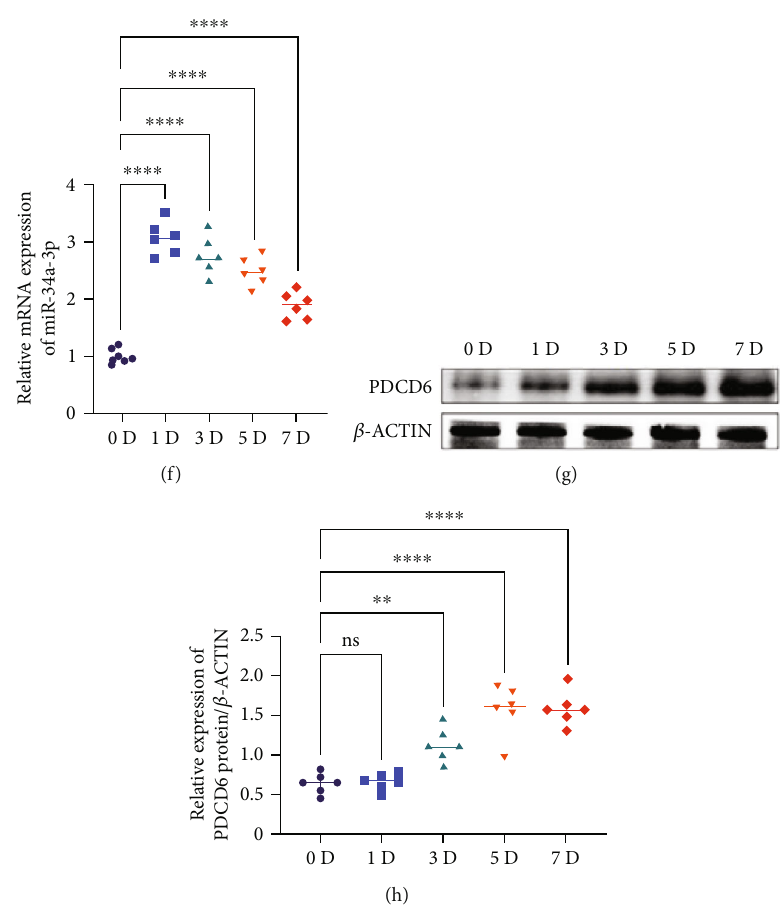
Figure 1: miR-34a-3p suppressed PDCD6 expression in di ff erentiating NSCs time-dependently. (a) Phenotypic characterization of isolated NSCs. The cells were stained for Nestin, GFAP, β III tubulin, and Olig2 to determine their expression on NSCs. The representative images of six ( n = 6 ) independent experiments are shown for each group. (b) miR-34a-3p directly binds to the 3 ′ UTR of PDCD6 (position 737-743); the sequence marked in red represents the predicted miR-34a-3p binding site (with vertical lines indicating base pairing underneath) or mutated miR-34a-3p binding site (unable to bind to the miR-34a-3p sequence). (c) Relative luciferase activity of Renilla luciferase versus fi re fl y luciferase in di ff erent groups. The experiments were performed in triplicate and repeated six times ( n = 6 independent experiments). (d) Western blot analysis of PDCD6 protein expression in di ff erent treatment groups. Representative images of three independent experiments are presented. (e) Quanti fi cation of western blot bands of PDCD6. The gray values of six ( n = 6 ) independent experiments were plotted. (f) qRT-PCR evaluation of NSCs di ff erentiation-dependent evolution of miR-34a-3p expression at di ff erent time points. The experiment was done in triplicate and repeated six times. (g) Western blot analysis of PDCD6 protein expression in di ff erentiating NSCs. Representative images of six ( n = 6 ) independent experiments were presented. (h) Quanti fi cation results of western blot analysis of PDCD6. The experiments were performed in triplicate and repeated six times ( n = 6 independent experiments). For the luciferase, qRT-PCR, and western blotting experiments, the one-way ANOVA followed by the Tukey ’ s multiple comparisons test was utilized to detect the di ff erences among the control group or 0d group and the other groups. ∗∗ p < 0 : 01 , ∗∗∗ p < 0 : 001 , ∗∗∗∗ p < 0 : 0001 , and ns: nonsigni fi cant among the compared